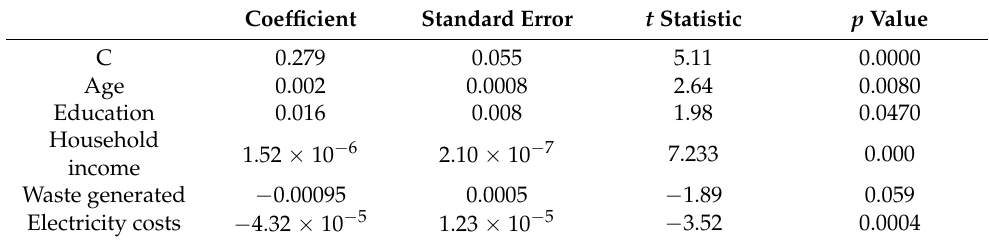
Table 5. Results of regression analysis.